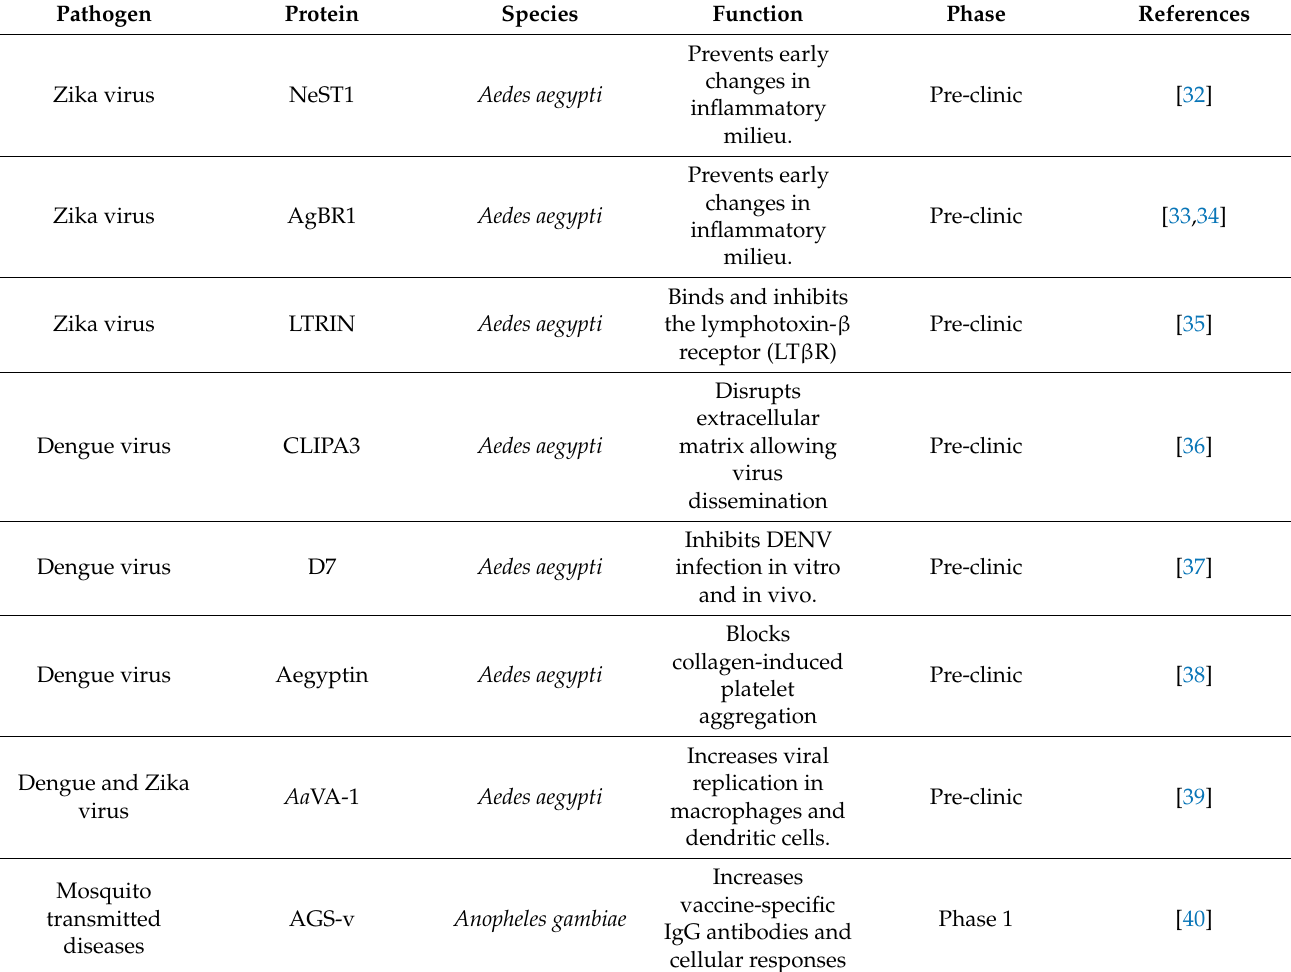
Table 2. List of salivary proteins studied as potential vaccine